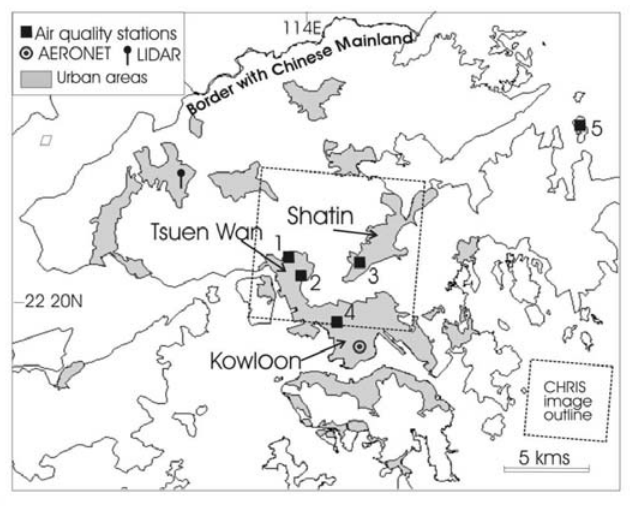
Figure 1. Urban areas in Hong Kong in relation to the area covered by the CHRIS image on 27-Sep-2006, and locations of AERONET, Lidar, and four urban air quality stations: 1. Tsuen Wan, 2. Kwai Chung, 3. Sham Shui Po, 4. Shatin, and 5. Tap Mun (rural